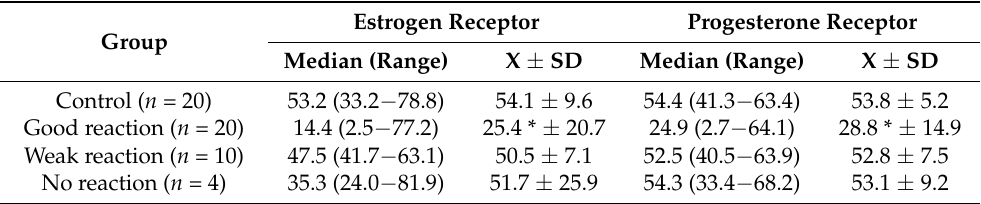
Figure 2. Representative light micrographs of ER and PR immunoexpression in myoma cells (brown-stained nuclei) in the control group ( A , E ); in the group with good reaction to UPA (ulipristal acetate) treatment ( B , F ); in the group with weak reaction to UPA treatment ( C , G ) and in the group with no reaction to UPA treatment ( D , H ). A – D : ER immunoexpression; E – H : PR immunoexpression. Scale bar—100 µ m. C—control group; ER—estrogen receptor; GR—good reaction to treatment; PR—progesterone receptor; WR—weak reaction to treatment; NR—no reaction to treatment. Table 3. The percentage of ER-positive and PR-positive cells in fibroids in the control group and in the study groups after three months of treatment with ulipristal